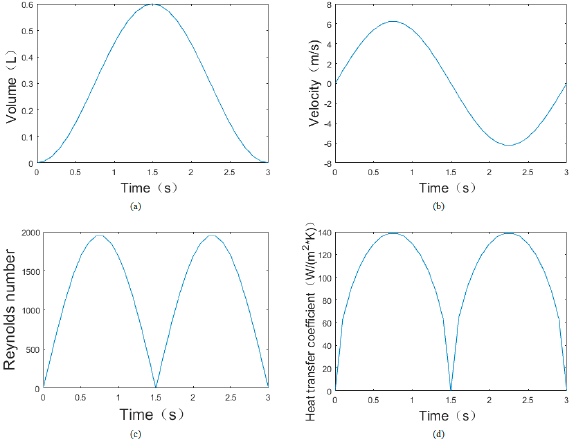
Figure 2. ( a ) The lung gas-volume variations with time; ( b ) the nasal airflow-velocity variations with time; ( c ) the Reynolds-number variations with time; ( d ) the convective heat-transfer coefficient var- iations with time.